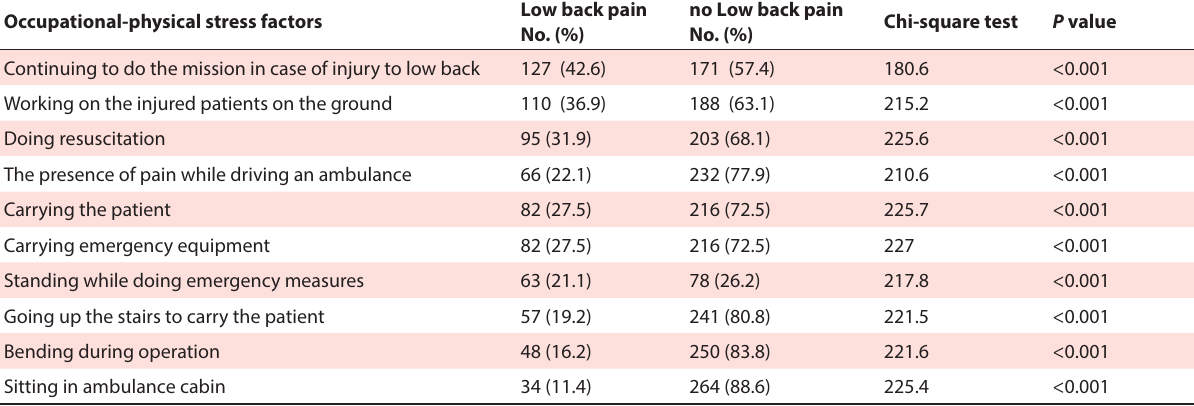
Table 2. Frequency distribution of occupational-physical stress factors in pre-hospital emergency personnel and its relationship with low back pain Occupational-physical stress factors